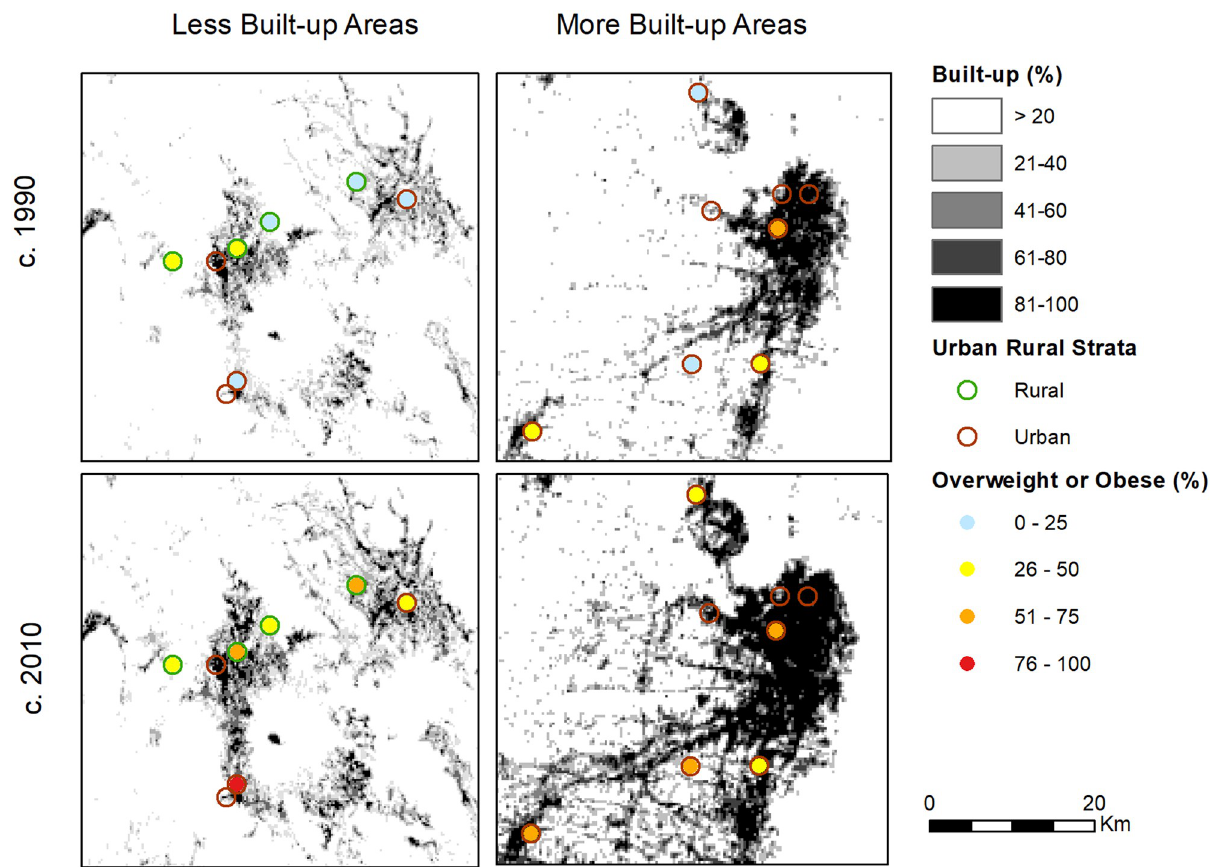
Fig 3. Built-up area close-ups with example, anonymized cluster locations, IFLS. NB: Maps are shown without identifying information to protect the confidentiality of survey respondents. Percent of cluster population that is overweight or obese is shown as this is the dependent variable, though the unit of analysis is individual not cluster as shown. Percentages are not given for any cluster with fewer than 10 respondents in any of the four